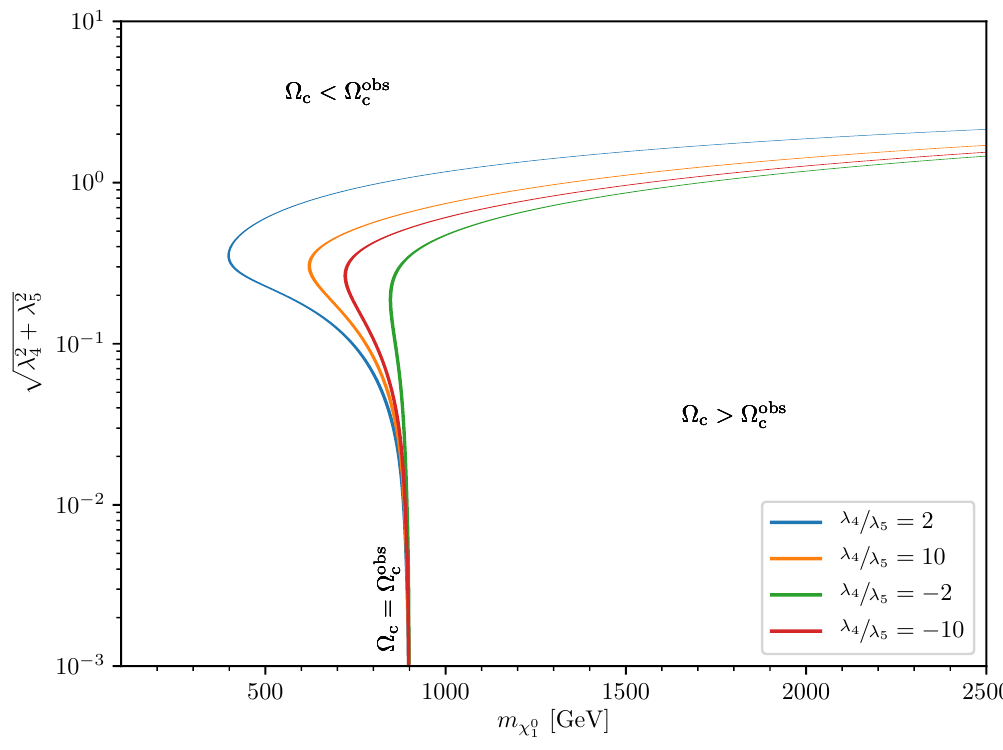
Figure 2 . The observed relic density contours ((cid:10) obs large relic density, as a function of the singlet-doublet fermion DM mass m couplings